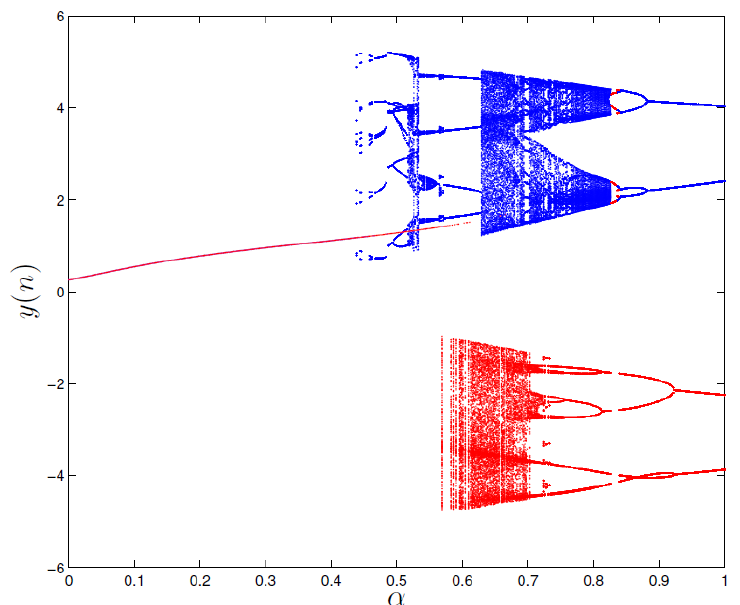
Figure 5. Coexisting multiple bifurcation diagram versus α for a 1 = 2.1, a 2 = 0.8, a 3 = 0.3, where the blue diagram is for IC ( 1,2 ) and the red diagram for ( − 1, − 2 ) .